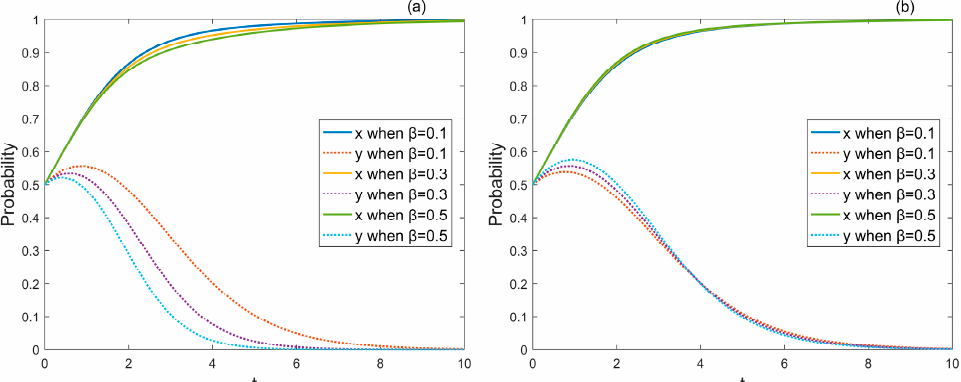
Figure 4. The impact of the dependence of herders on non-grazing livelihoods in the evolutionary game . ( a ) alternative livelihood differentiation model; ( b ) complementary livelihood differentiation model.